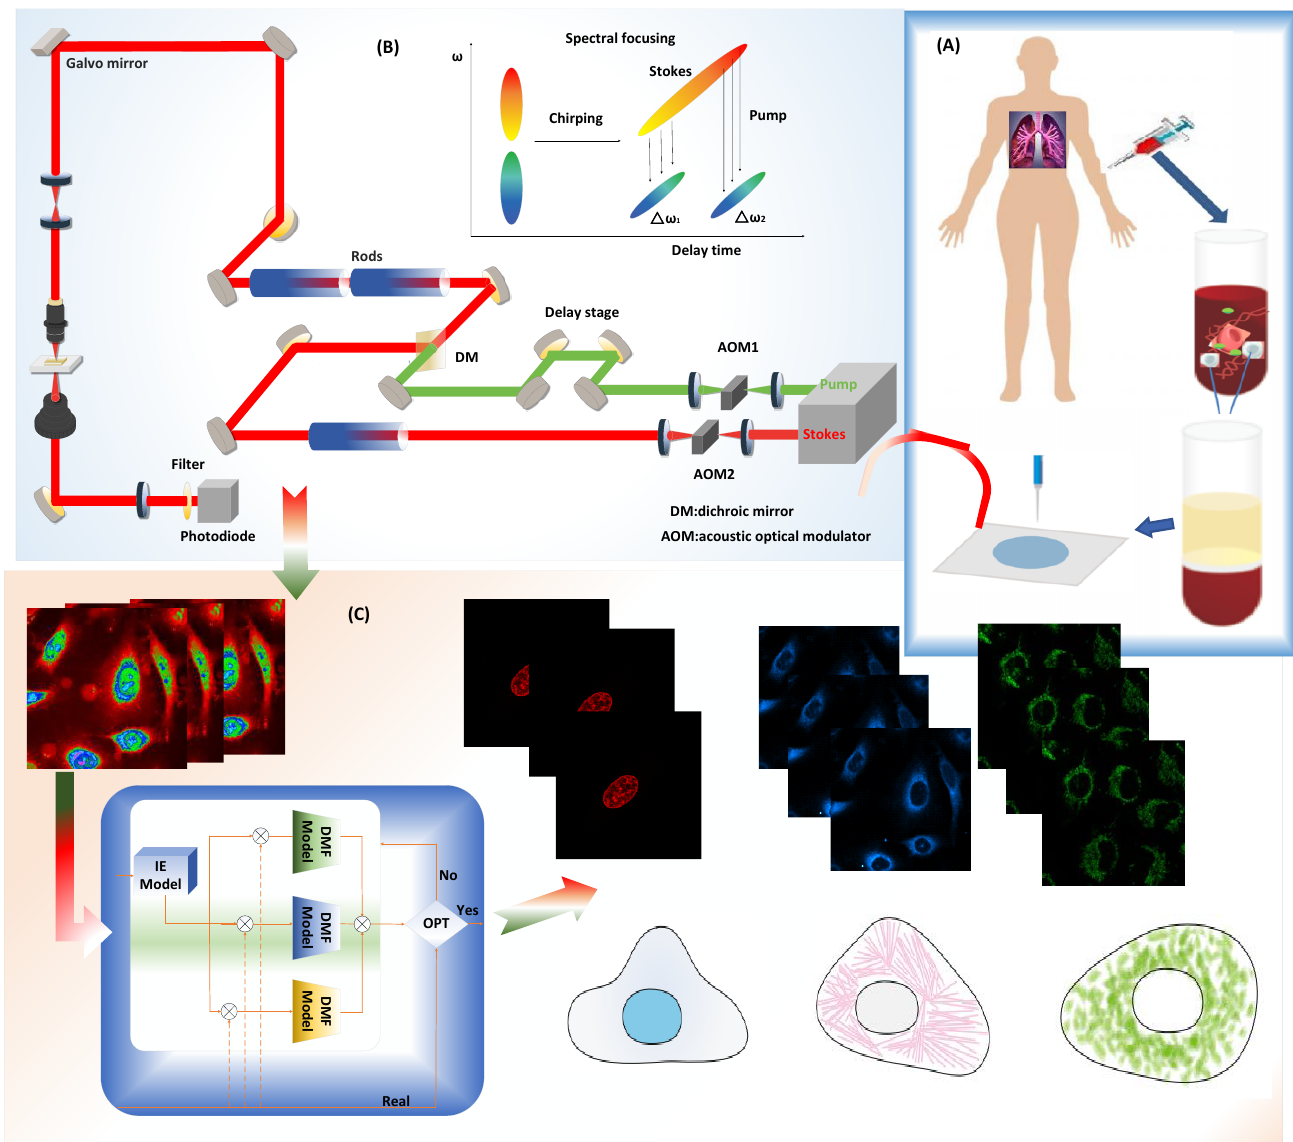
Figure 11. Workflow of the Single-Cell experiment by Stimulated Raman Scattering Imaging and deep learning model prediction process. ( A ) The process of prepearing the lung cancer cell sample. ( B ) Stimulated Raman Scattering microscopy setup for collecting SRS signal of the lung cancer cell samples. ( C ) Different machine learning techniques for the subcellular protein localization of lung cancer cells.